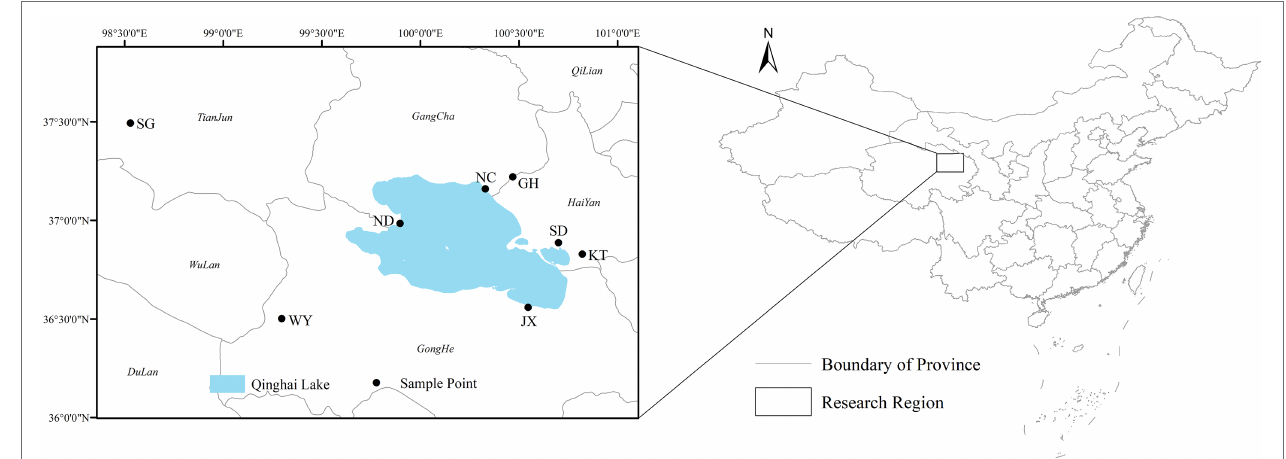
FIGURE 1 | The eight geographical regions of the fecal samples of Przewalski’s